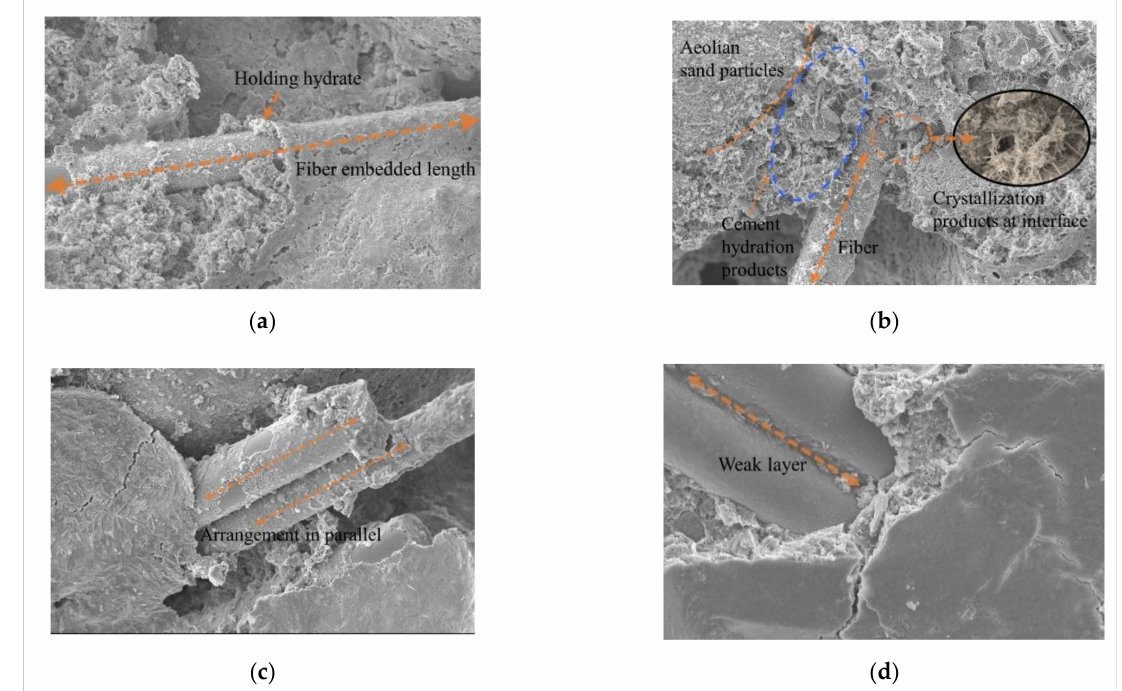
Figure 10. Microscopic characterization of fiber-reinforced cement-solidified aeolian sand. ( a ) Image of single-fiber gripping effect (1000 × ); ( b ) Bond image of steel-sand interface (1000 × ); ( c ) Image of parallel arrangement of fibers (1000 × ); ( d ) Weak layer after fiber superposition (1000 ×